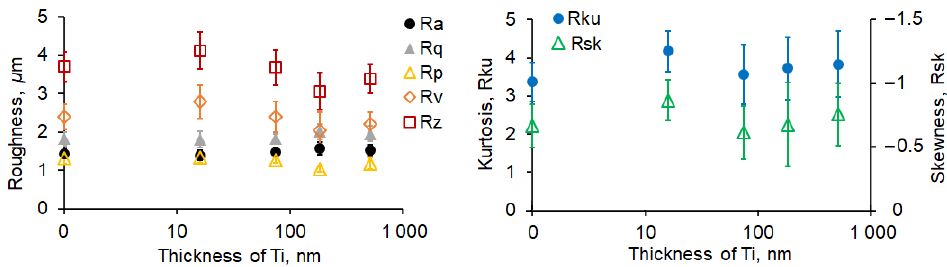
Figure 2. Influence of sputtered Ti layer thickness on surface roughness of hard anodized 6082 alloys.